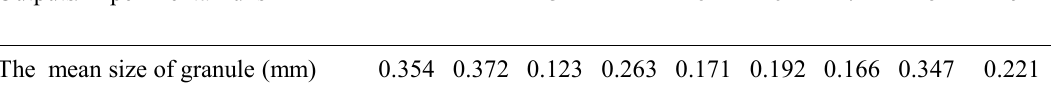
Column assignment for the various outputs in the Taguchi’s L9(3 4 ) orthogonal array. Outputs/Experimental runs The mean size of granule